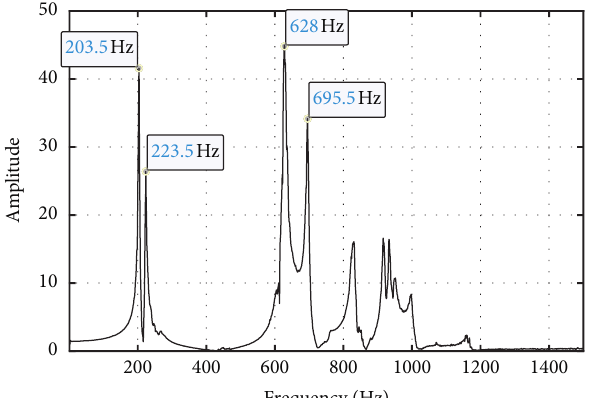
Figure 6: FTF for cargo bolts in normal condition.